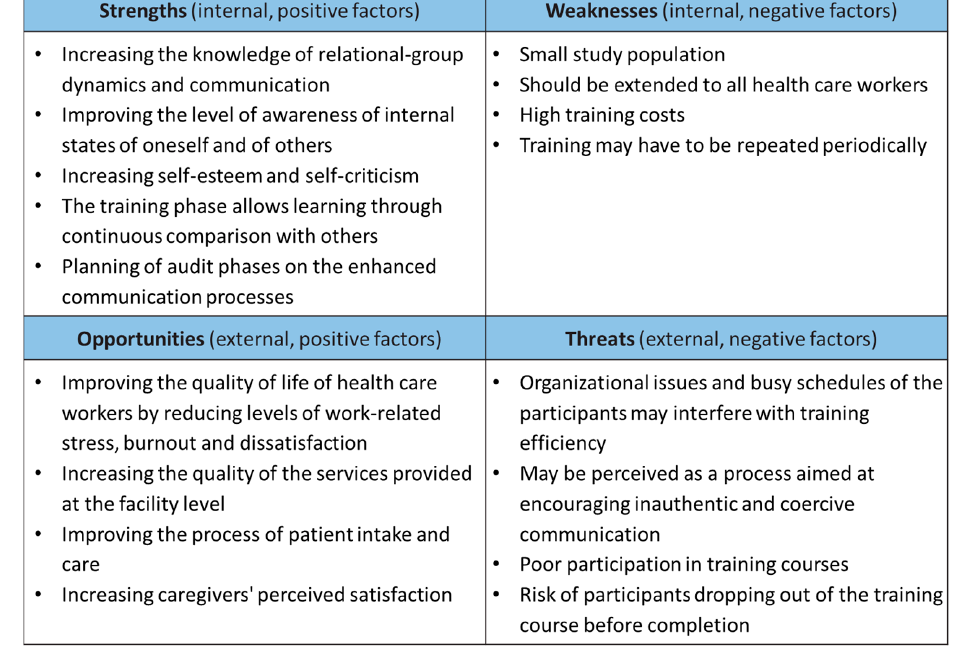
Figure 2. SWOT analysis chart.